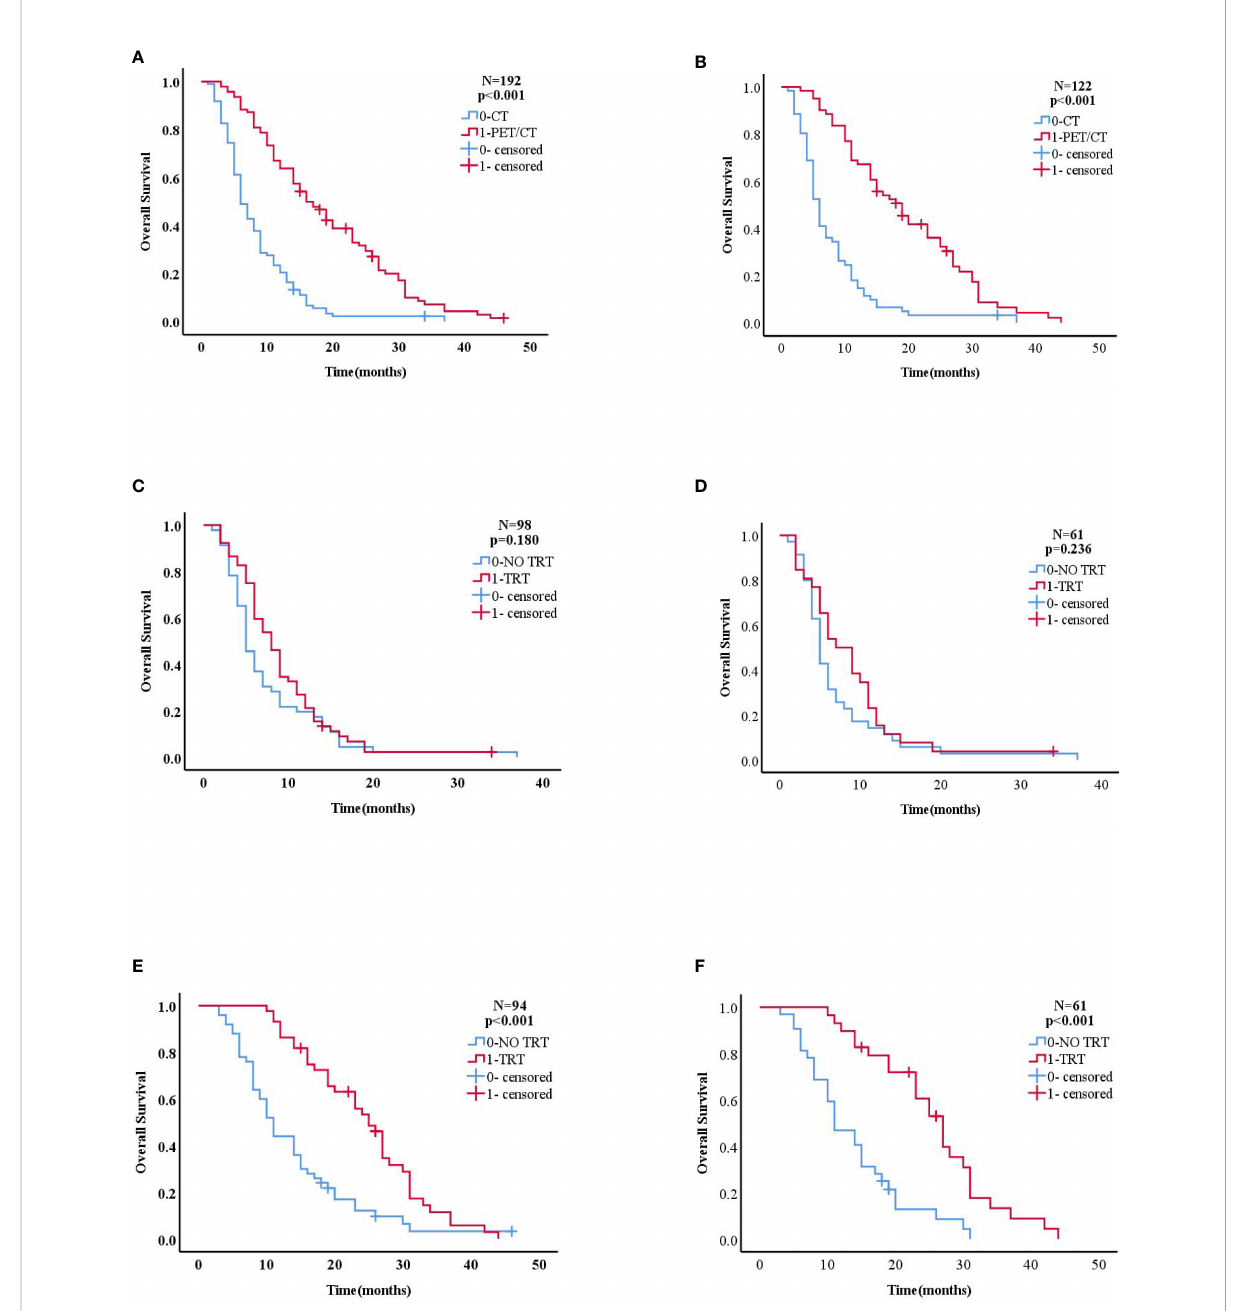
FIGURE 2 (A, B) Kaplan – Meier curve of overall survival for patients who did and did not receive PET/CT in the overall population (before PSM n=192,after PSM n=122). (C, D) Kaplan – Meier curve of overall survival for patients who did and did not receive TRT in the CT group (before PSM n=98,